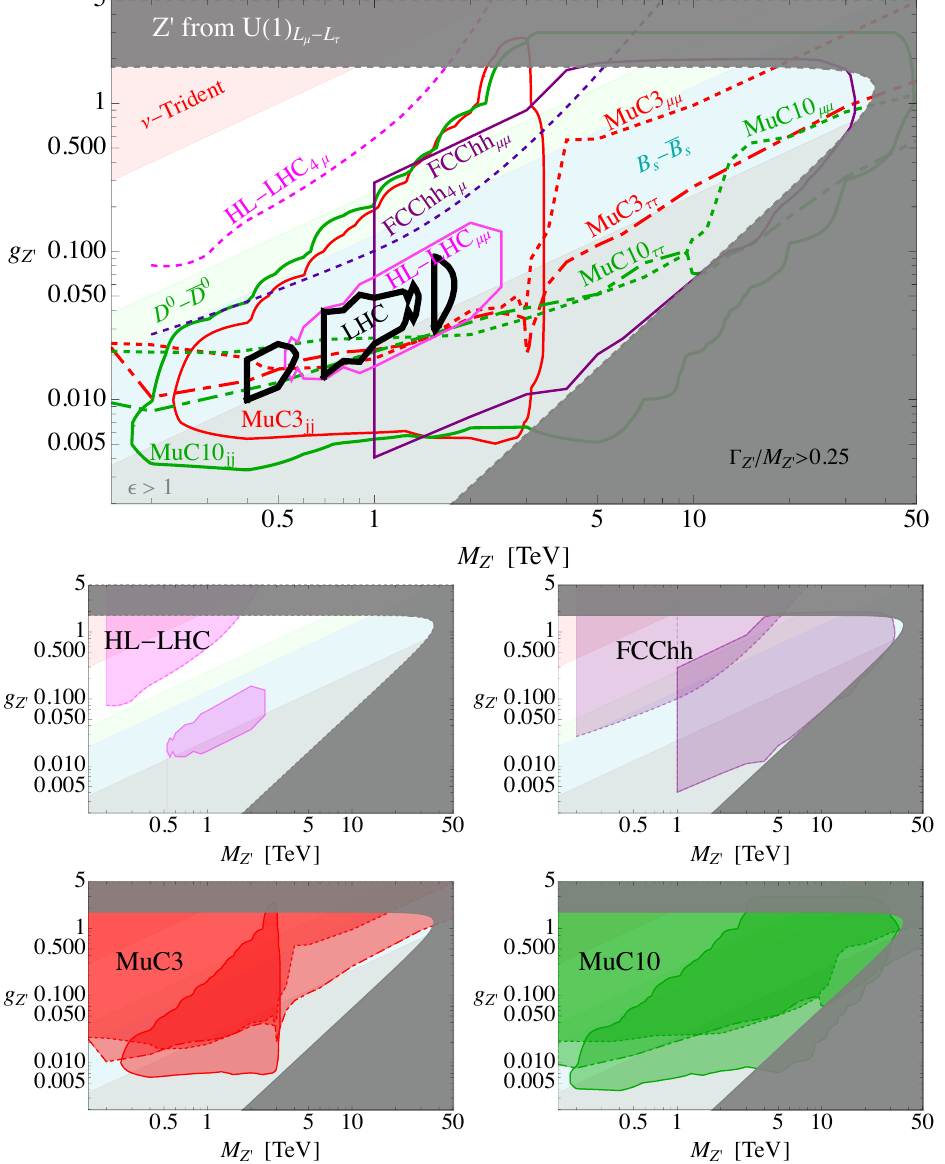
Figure 12 . Discovery reach at 5 σ for the L µ − L τ model. The fit to bsµµ anomalies is imposed, eq. (5.8). The regions excluded by B s and D 0 mixings and neutrino trident production are colored in light blue, green and red, respectively. The light gray region requires (cid:15) > 1 to fit b → sµµ anomalies, while the dark gray region has Γ Z 0 /M Z 0 > 0 . 25 . Our recast of the present LHC search [88] excludes at 95% CL the region inside the thick black lines. The discoverable region at future colliders is the one on the side of the line where the corresponding label has been drawn. The smaller figures below the main figure highlight a single future collider at a